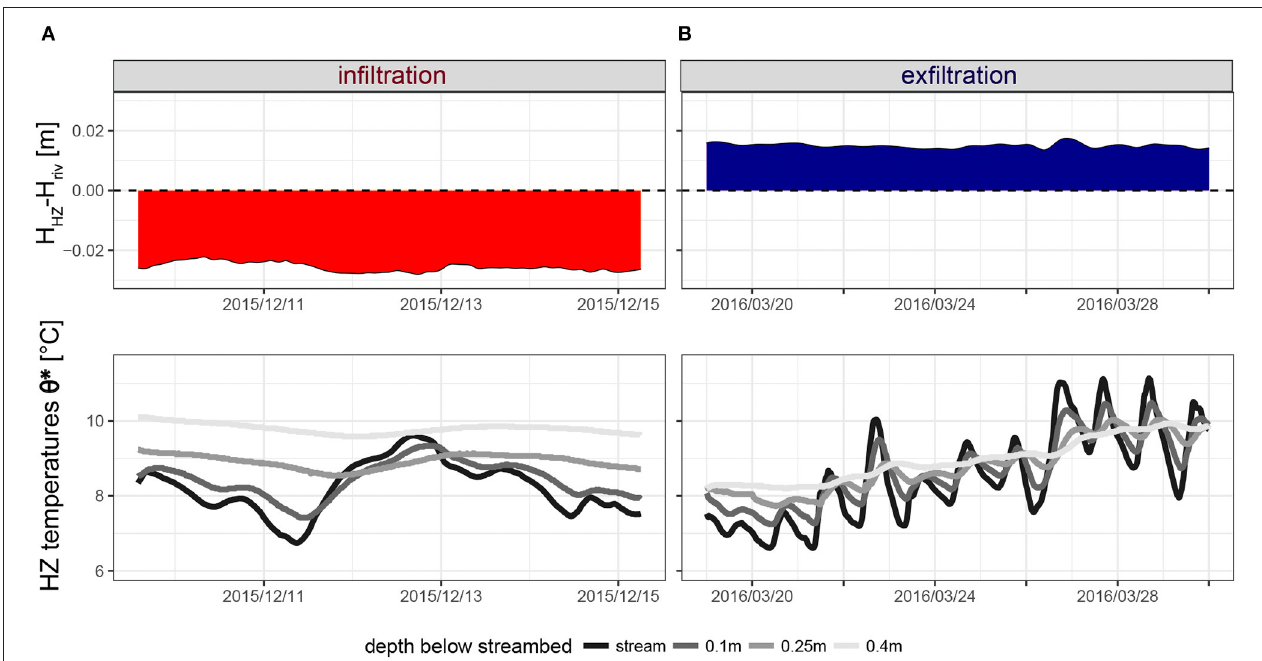
FIGURE 6 | LOMOS-mini measurement data sets used to estimate hydrothermal properties and fluxes. Top row: pressure head difference 1 H . Bottom row: HZ 1D vertically-distributed temperatures. Two configurations are presented: (A) infiltration case study and (B) exfiltration case